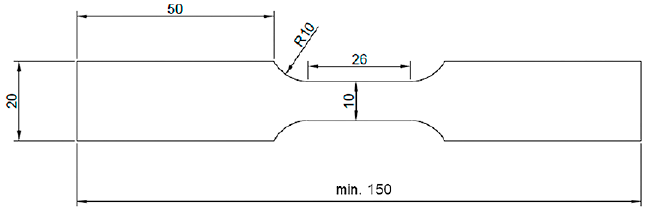
Figure 2. Scheme of sample for fatigue testing. All dimensions are in mm. Thickness is equal to 5 mm.